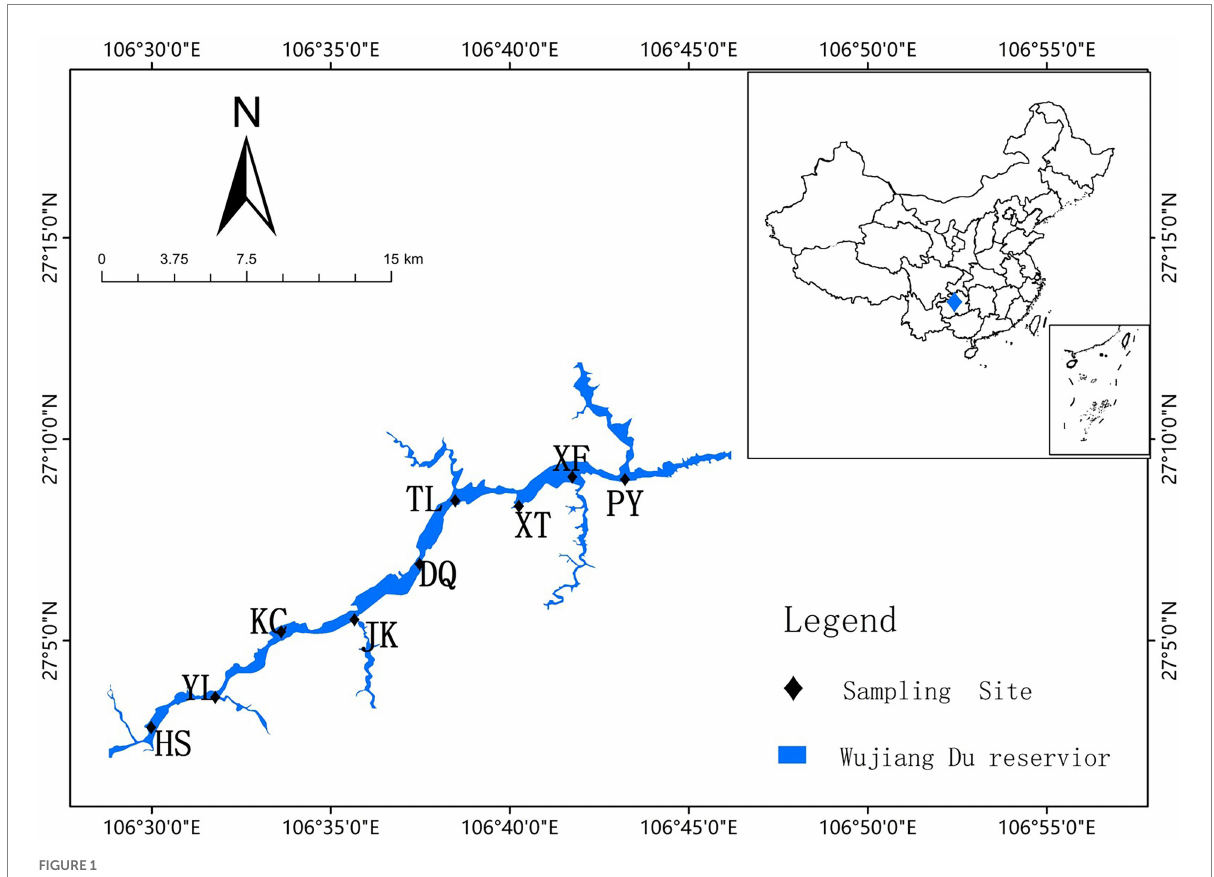
FIGURE 1 Sampling locations of Wujiangdu Reservoir along the Wujiang